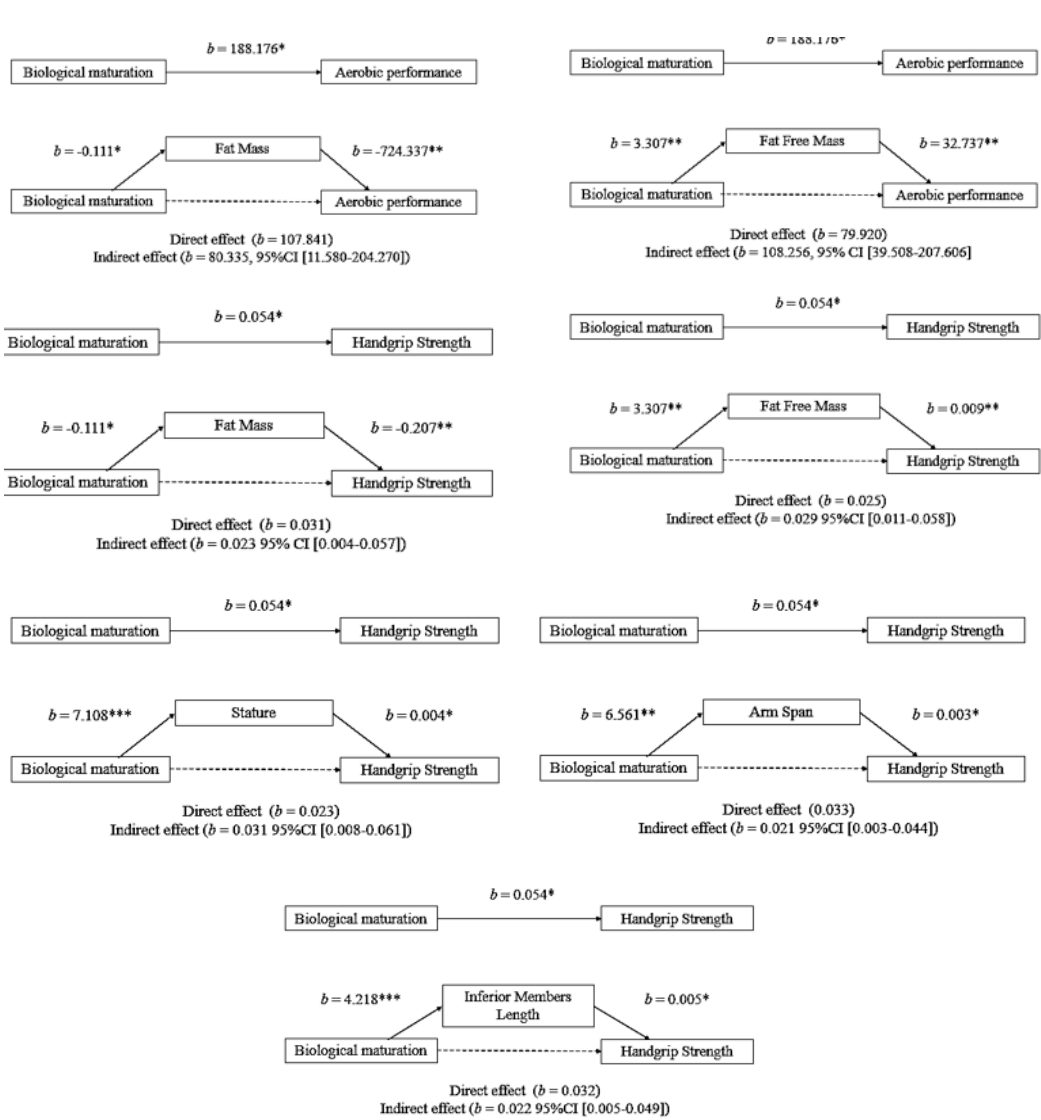
Figure 1. Models of body fat mass, body fat free mass, stature, arm span, and inferior members length mediation on the maturational e ff ect on aerobic performance and handgrip strength. * p < 0.05; ** p < 0.01; *** p < 0.001; solid line, significant e ff ect; dash line, non-significant e ff ect.